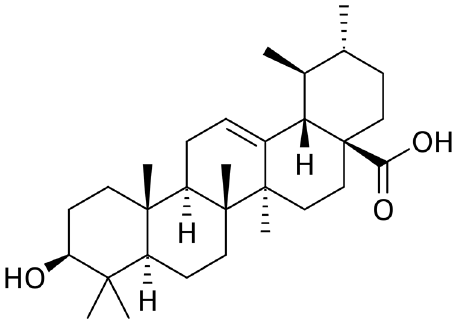
Figure 1. Chemical formula of ursolic